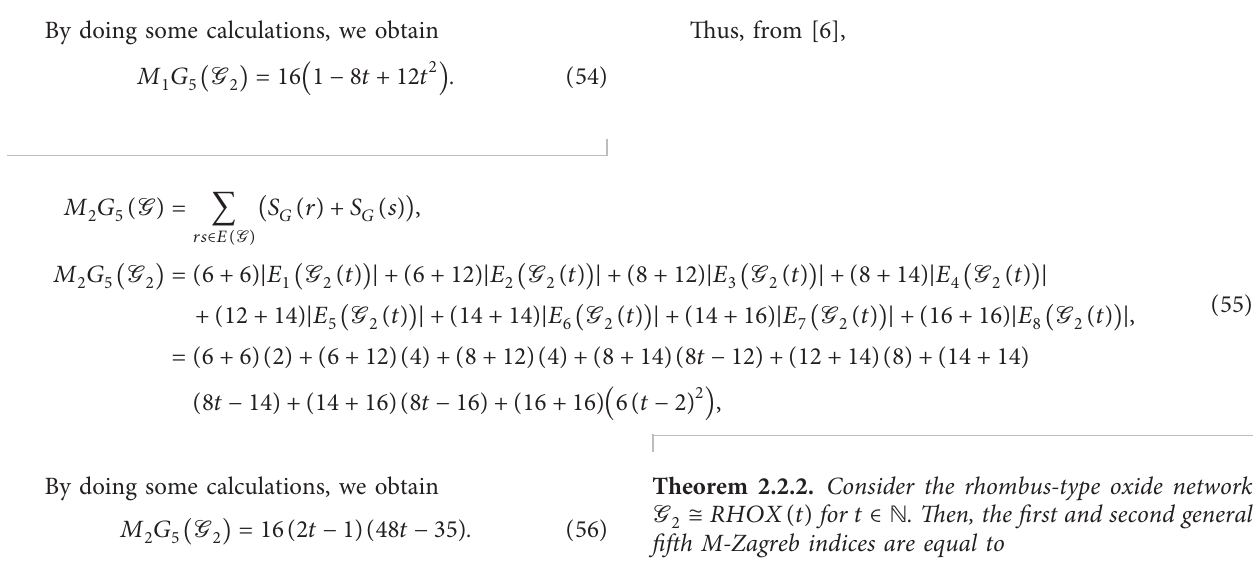
Table 2: Edge partition of rhombus-type oxide network ( RHOX ( t ) ) based on sum of degrees of end vertices of each edge. , S ) Number of edges ( S r s ) Where rs ∈ E ( G 2 ( 6 , 6 ) 2 ( 6 , 12 ) 4 ( 8 , 12 ) 4 ( 8 , 14 ) 4 ( 2 t − 3 ) ) Where rs ∈ E ( G 2 ( 12 , 14